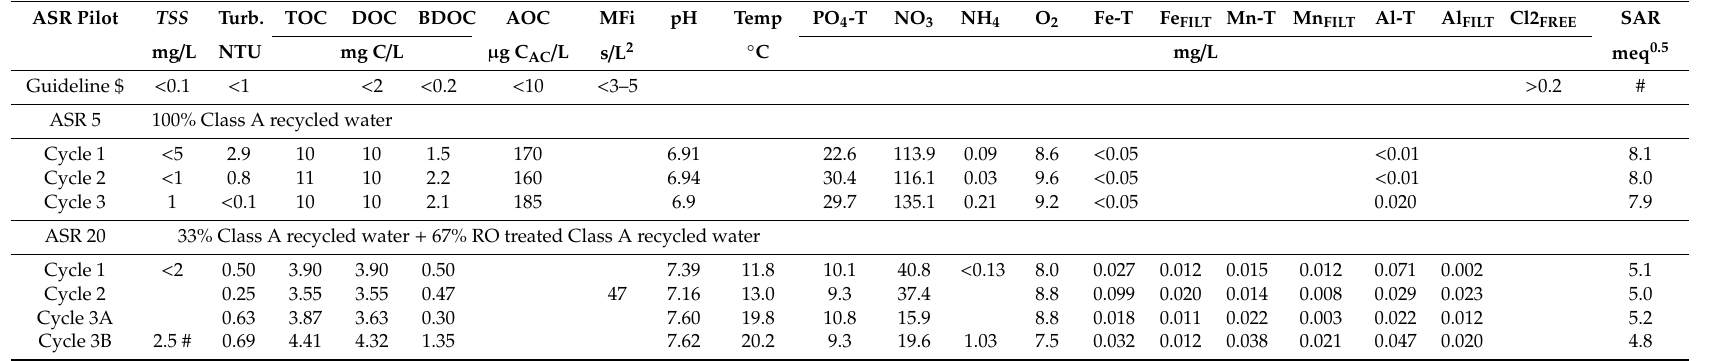
Table 5. Overview of parameters that have a potential impact on well clogging, and their average concentration or value in the infiltration water during the three cycles of each pilot. For several parameters a guideline value for deep well recharge is